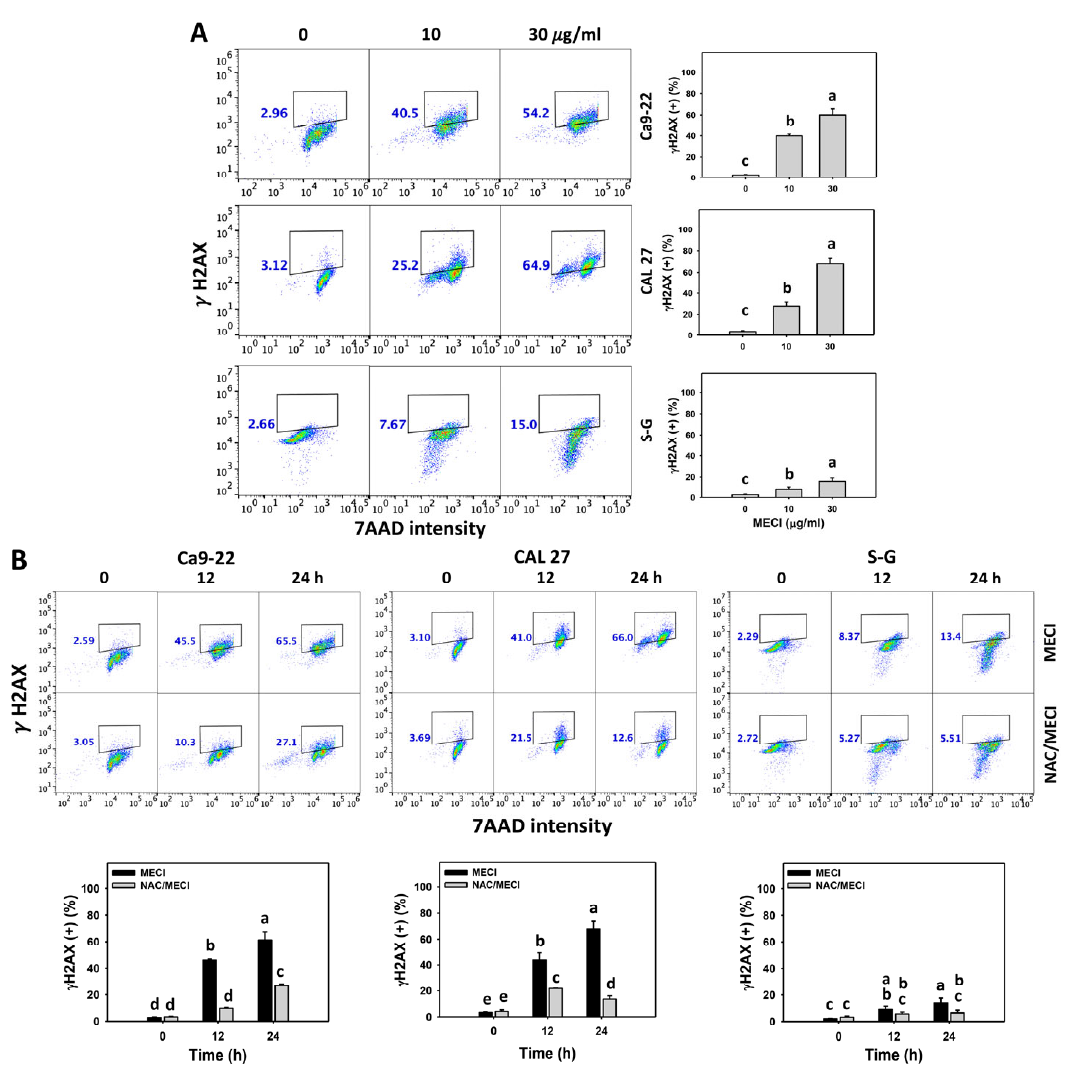
Figure 9. γ H2AX assay. ( A ) γ H2AX change. Except for S ‐ G cells, other cells were oral cancer cells. After 24 h MECI incubation (0 (0.1% DMSO in the medium), 10, and 30 μ g/mL), cells were applied to γ H2AX assays. (+) spots were specified for γ H2AX (+). ( B ) Impact of NAC on MECI ‐ induced γ H2AX change to oral cancer cells. After pretreatment with NAC, cells were post ‐ treated with MECI (30 µ g/mL) for 0, 12, and 24 h. Data, mean ± SD ( n = 3). For the same cell line, columns showing non ‐ overlapping letters differ significantly ( p < 0.05).